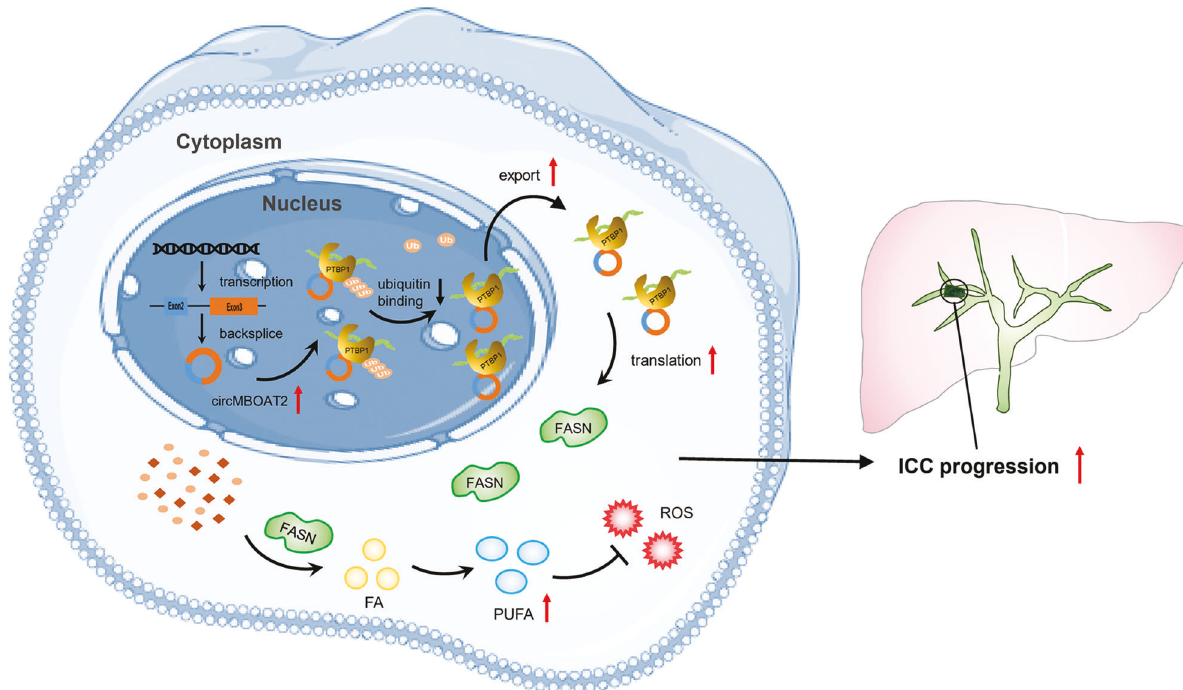
Fig. 9 Proposed working model for promotional effects of circMBOAT2 on ICC progression. CircMBOAT2 derives from the exons 2 – 3 of the MBOAT2 gene by backsplicing in the nucleus and exporting to the cytoplasm. CircMBOAT2 stabilized PTBP1 to facilitate FASN mRNA cytoplasmic export, which altered the lipid metabolic pro fi le and regulated redox homeostasis in ICC, thus promoting tumor